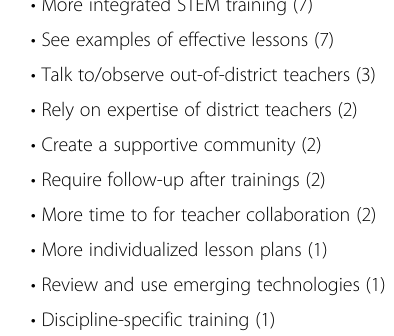
How to improve in-service